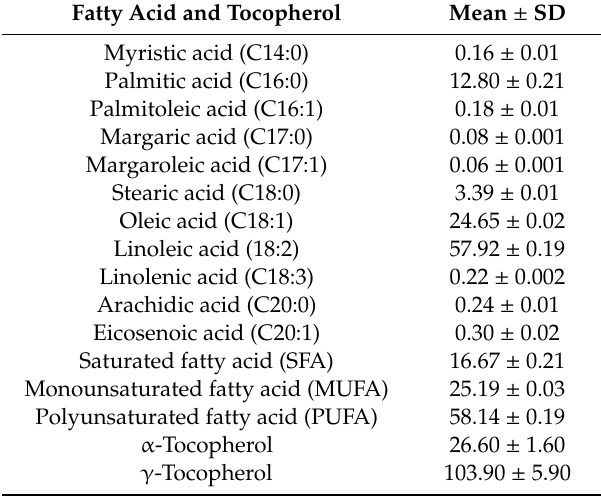
Table 1. Fatty acid (%) and tocopherol composition (mg / kg) in Nigella sativa oil. Fatty Acid and